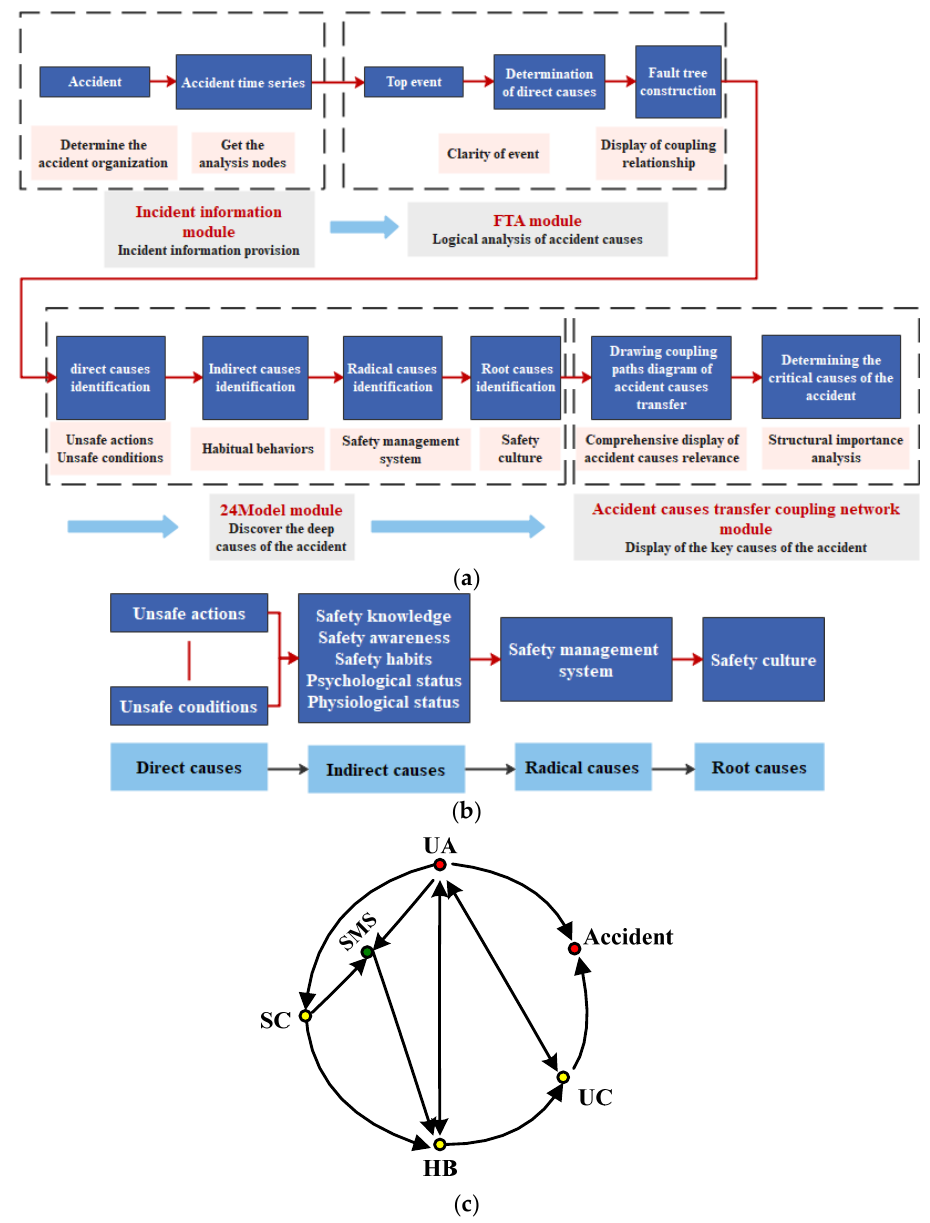
Figure 1. Model of the framework of accident cause analysis based on the FTA-24Model. ( a ) Framework analysis path diagram; ( b ) Static structure of 24Model module; ( c ) Dynamic structure of 24Model module.